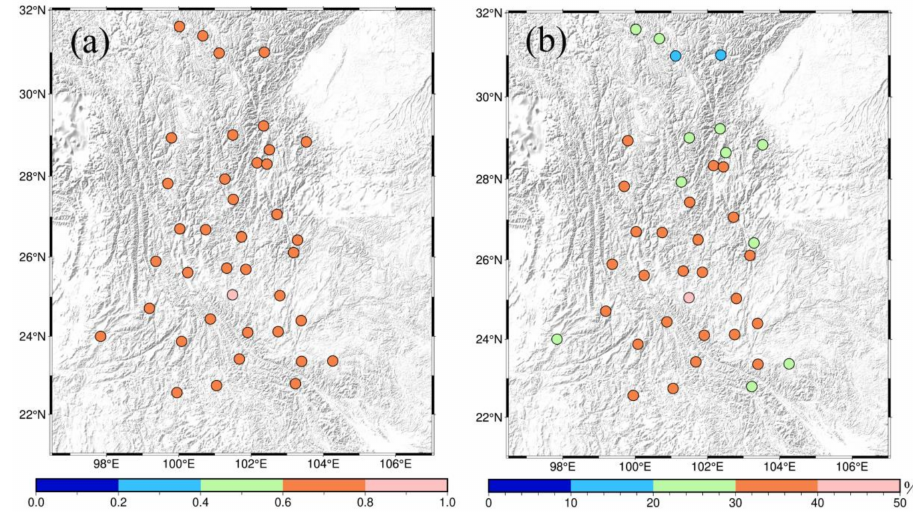
Figure 12. Correlation ( a ) and RMS reduction ( b ) between CME and HYDL time series provided by EOST at all stations in the Chuandian region.